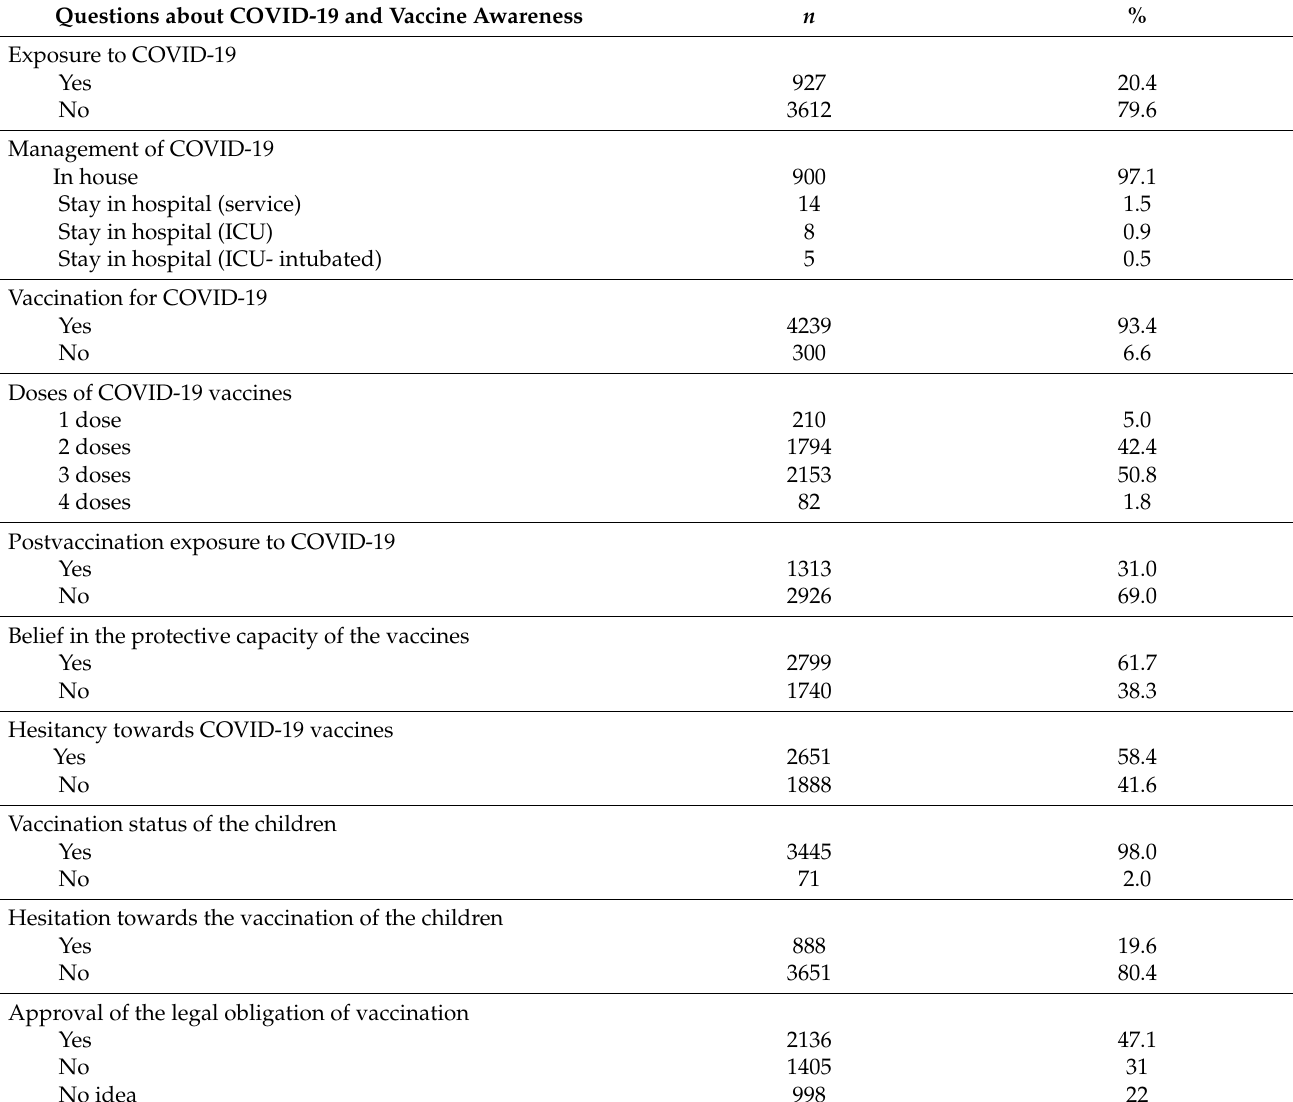
Table 3. Distribution of answers of the participants to questions about COVID-19 infection, COVID-19, and routine vaccination of